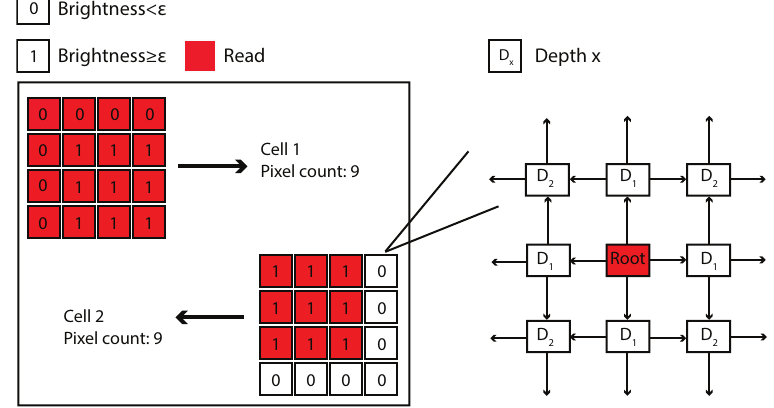
Figure 2. Illustrative demonstration of BFS